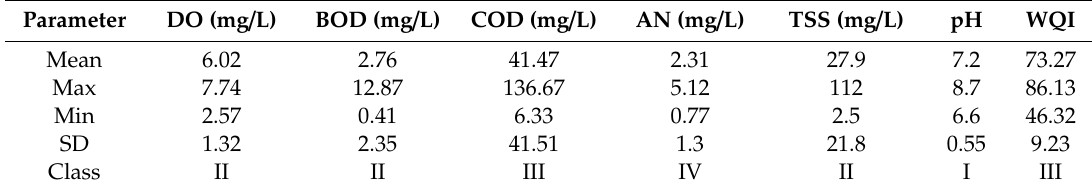
Table 9. Summary of the input and output parameters for the dry